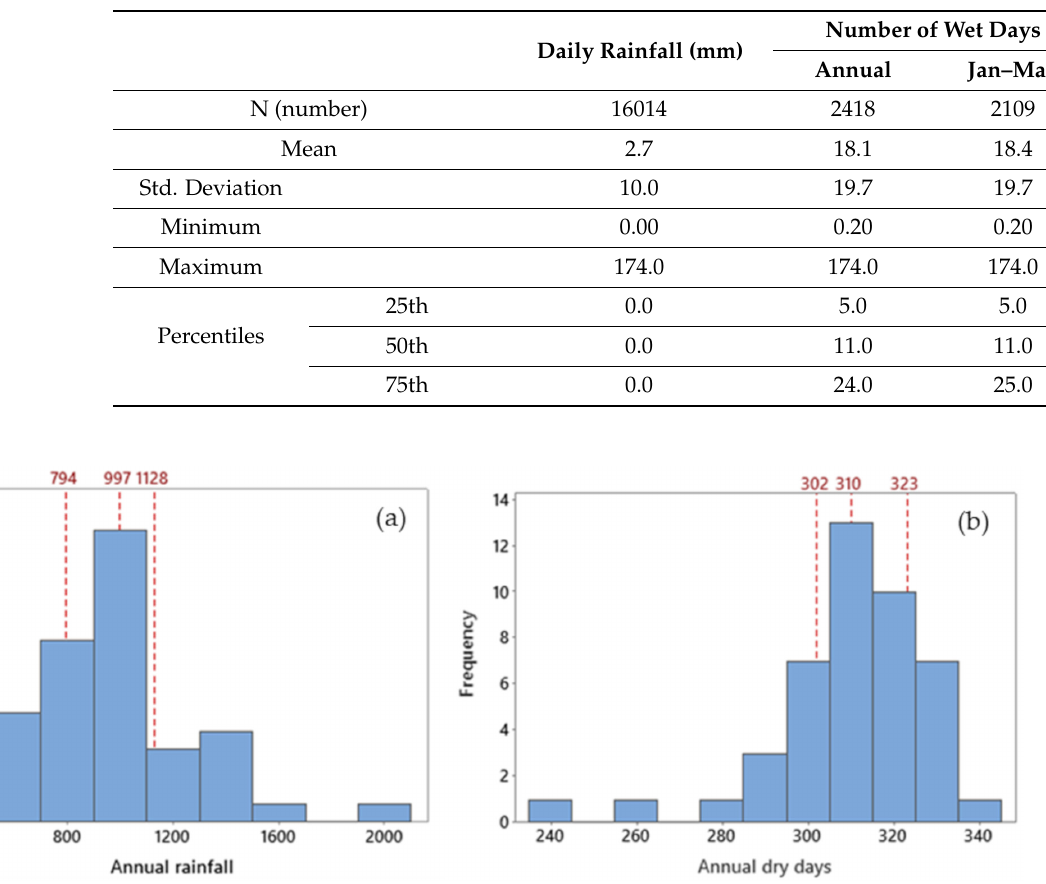
Figure 5. Histogram of ( a ) annual rainfall and ( b ) number of dry days (DD)